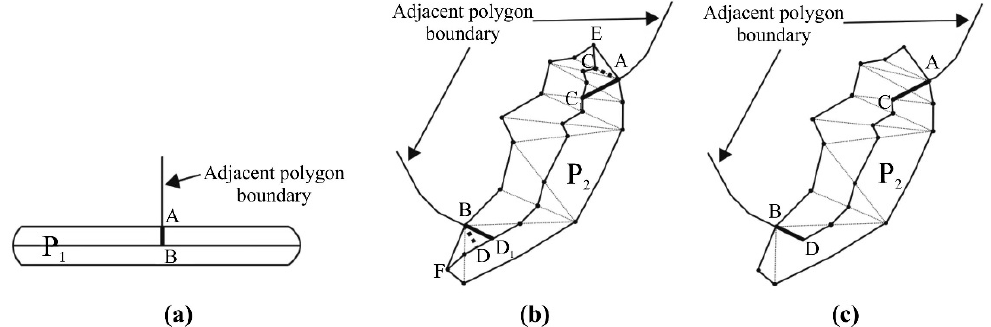
Figure 12. Split line topology correction method for nodes with degree 1: ( a ) closest point method, ( b ) reverse extension method and ( c ) dangling skeleton line removal.